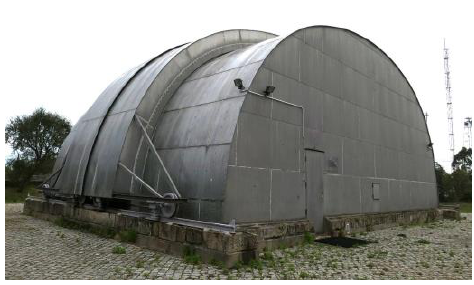
Figure 4 . Building used for calibration tests.